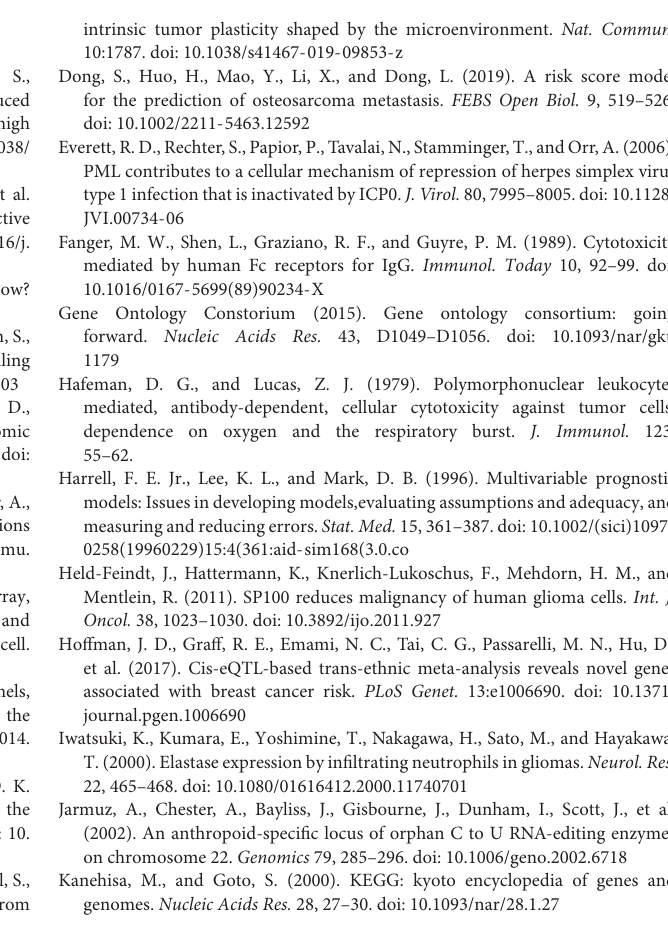
FIGURE S1 | The normalization and batch effect removal from TCGA and GTEx datasets. (A) Box plots illustrated the data distributions from TCGA and GTEx datasets before normalization. (B) PCA plot illustrated the cluster of the samples from TCGA and GTEx datasets before batch effect removal. (C) Box plots illustrated the data distributions from TCGA and GTEx datasets after normalization. (D) PCA plot illustrated the cluster of the samples from TCGA and GTEx datasets after batch effect removal. FIGURE S2 | (A) Heatmaps showing that the 5,490 differentially expressed genes (DEGs) can effectively distinguish tumors from non-tumor tissues after integrated analysis. (B) Volcano plot presenting DEGs between LGG and non-tumor tissues.